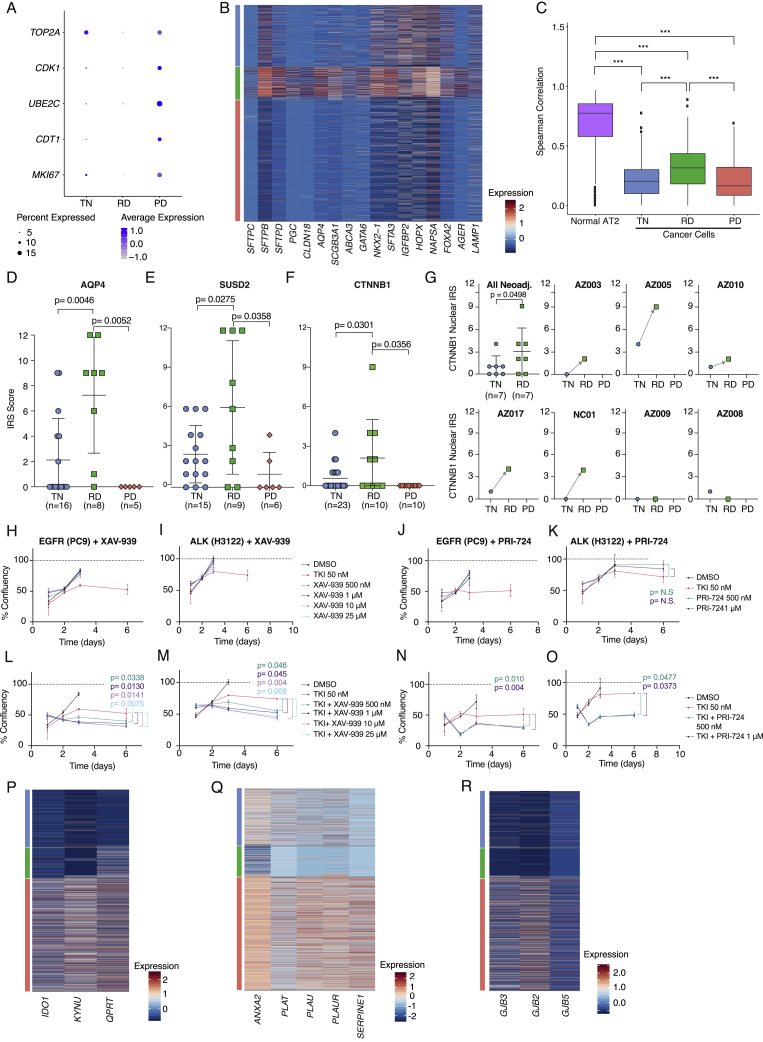
Related to Figure 3(A) Dot plot of the relative expression of established cellular proliferation genes (x axis) across treatment time points (y axis). The color intensity scale reflects the average gene expression and the size scale indicates the number of cells expressing the gene within that treatment time point. Applying grouped, pairwise comparisons of treatment time points of the average scaled expression of all genes demonstrated significantly different expression (p < 0.0001) in all comparisons. (B) Heatmap showing the expression of genes in the alveolar signature. Cells are grouped by treatment time point. (C) Boxplot of Spearman correlations of cancer cells from all treatment time points and healthy AT2 cells to an external reference of healthy AT2 cells. Non-cancer AT2 cells from our dataset were more similar to the external, healthy AT2 cells than any of our cancer cells across all time points (mean ρ = 0.65, −0.10, 0.24, −0.19, for healthy AT2 cells, and TN, RD, PD cancer cells, respectively). ∗∗∗ indicates a p value < 0.001 (D-F) Immunoreactivity score (IRS) for membrane AQP4 (D), membrane SUSD2 (E), and nuclear CTNNB1 (F) across all time points. (G) Pairwise comparison of nuclear CTNNB1 IRS for a subset of patients receiving neoadjuvant TKI treatment prior to surgical removal of tumors, allowing for controlled, matched sample pairs at TN and RD treatment time points. Samples with AZ identifiers refer to patients with EGFR mutant NSCLC receiving neo-adjuvant osimertinib treatment. Sample with NC identifier refer to patient with ROS1 fusion-positive NSCLC receiving neo-adjuvant crizotinib treatment. (H-O) High content microscopy screening of EGFR mutant PC9 cells and ALK fusion-positive H3122 cells showing treatment response to TKI in presence or absence of WNT/β-catenin inhibition. In comparison to DMSO control, upper panel (H-K) shows single agent treatment, lower panel (L-O) shows combinational treatment of TKI WNT/β-catenin inhibitors. Two WNT/β-catenin inhibitors have been tested, XAV-939 (H,I,L,M) and PRI-724 (J,K,N,O). Values are shown as percent confluency, with maximum cutoff for full well confluency (100%). p values are calculated for all end points (day 6) values compared to single agent TKI. Error bars represent mean ± standard error of the mean (SEM), n = 4 technical replicates. (P-R) Heatmaps showing the expression of genes within each signature (kynurenine, SERPINE1/plasminogen activation, and gap junction, respectively) grouped by treatment time point.